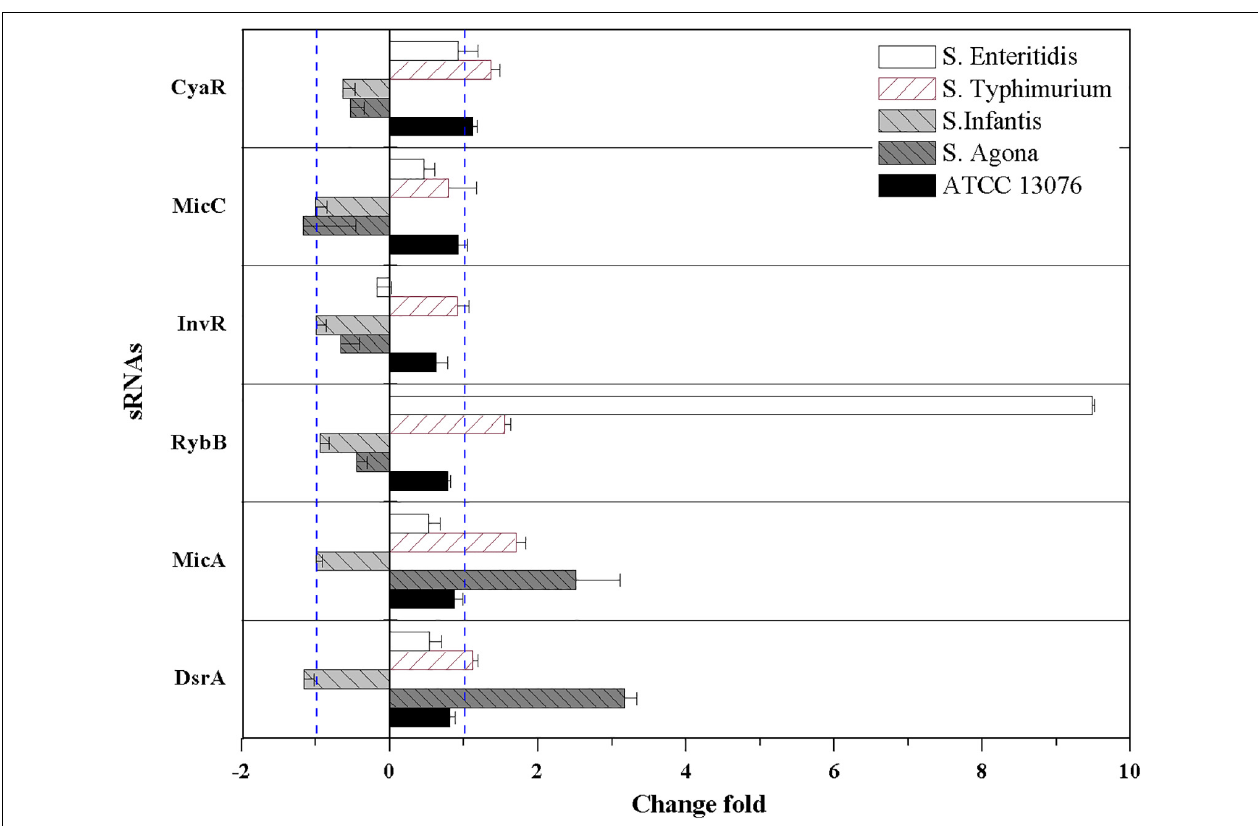
FIGURE 6 | The relative expression of sRNAs of five Salmonella strains when exposed to oxidative stress. Each symbol indicates the mean ± standard deviation of five independent experiments ( n =